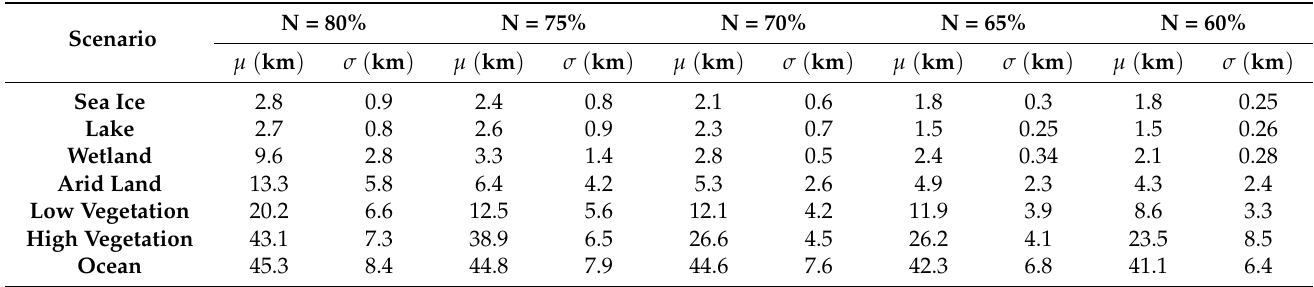
Table A1. Variable spatial resolution of GNSS-R measurements from SMAP-Reflectometer.